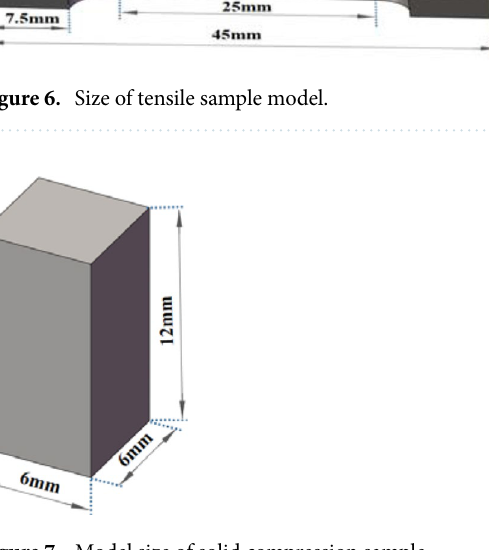
Figure 7. Model size of solid compression